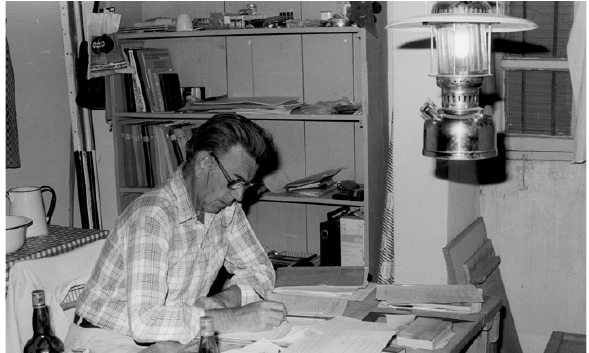
Figure 2. Friedrich W. Hinkel working in his rest house at Begrawiya/Meroe, 1983 (Negative No. D-DAI-Z-Arch-FWH-F- KB-sw-389-55, © Deutsches Archäologisches